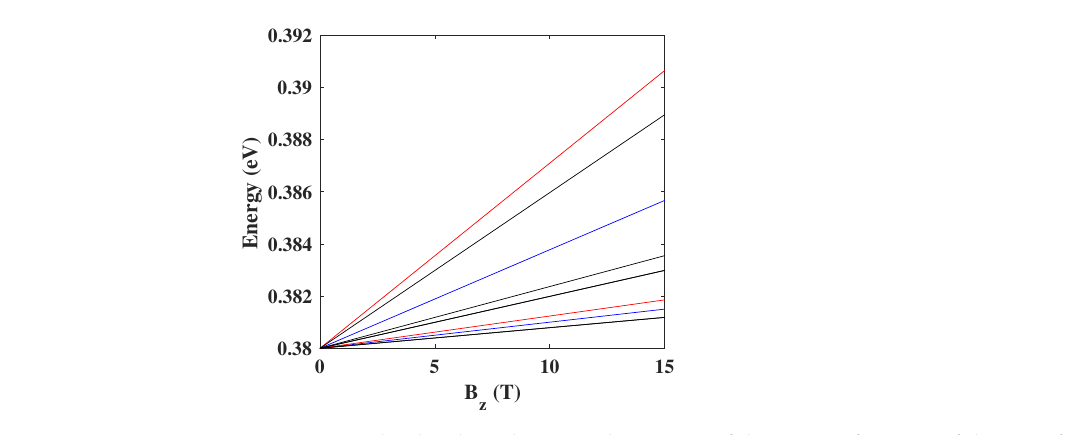
Figure 4. Landau levels in the CB at the Γ point of the BZ as a function of the out-of-plane magnetic field B z . Blue lines show E Γ and E Γ given below Equation (15) and red lines indicate the first two LLs 0 1 that can be obtained from the Ansatz in Equation (16). Black lines show the "conventional" LLs, see the text.